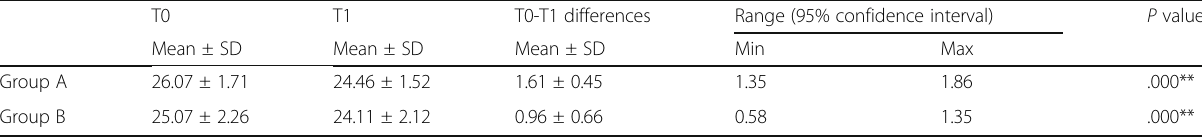
Table 1 Comparison of tooth length changes between pre-treatment and post-treatment in each group T0 T1 T0-T1 differences Range (95% confidence